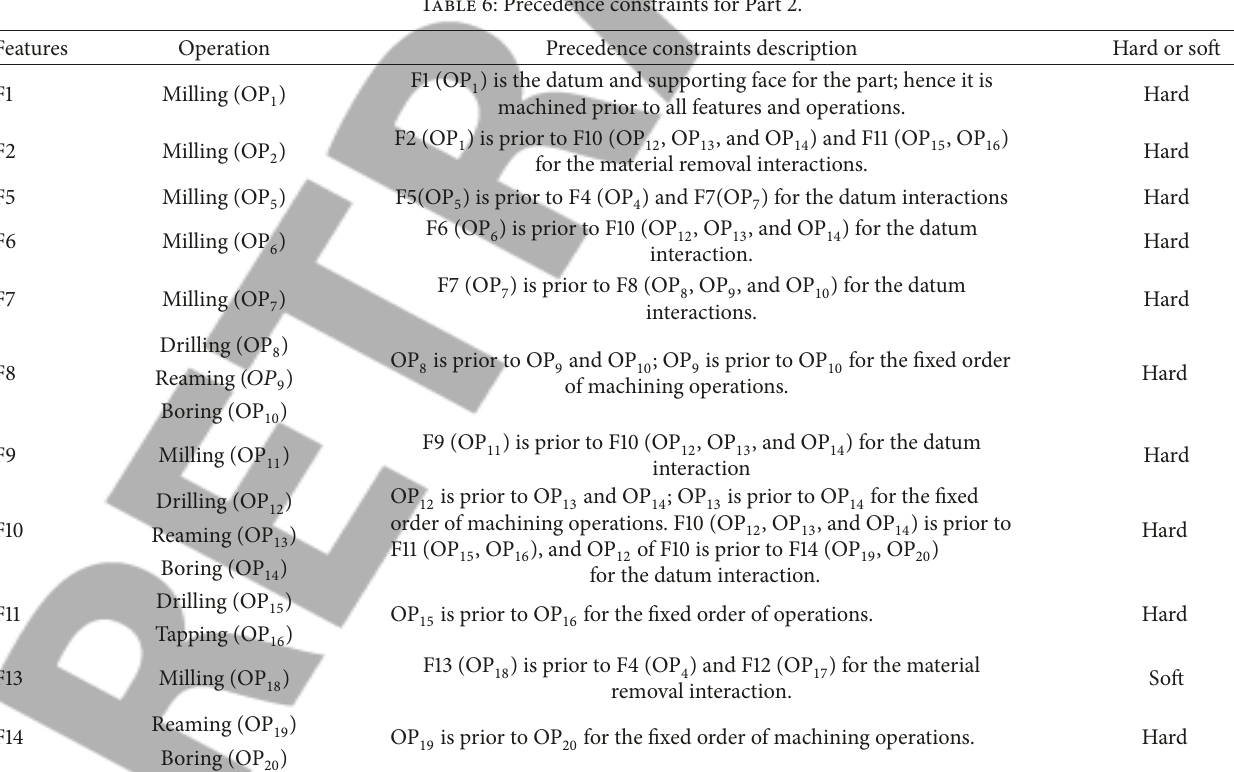
Table 6: Precedence constraints for Part